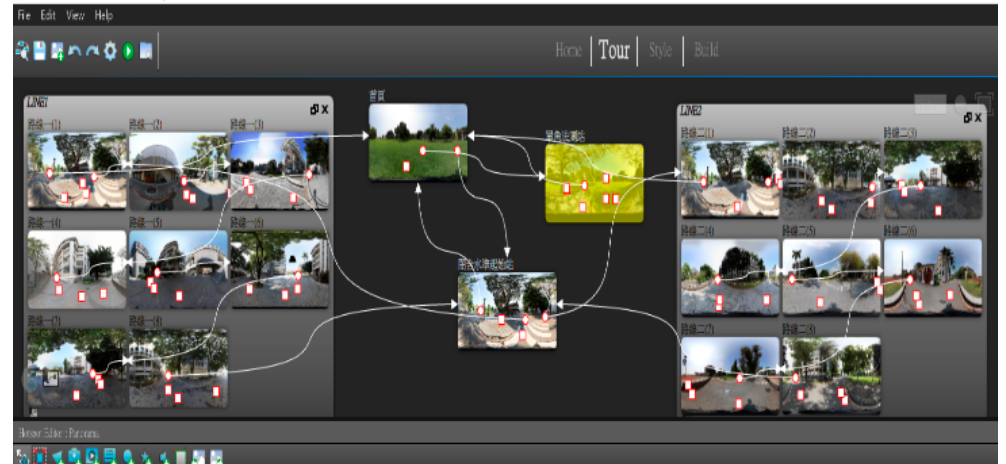
Figure 9. An example of setting a virtual tour.